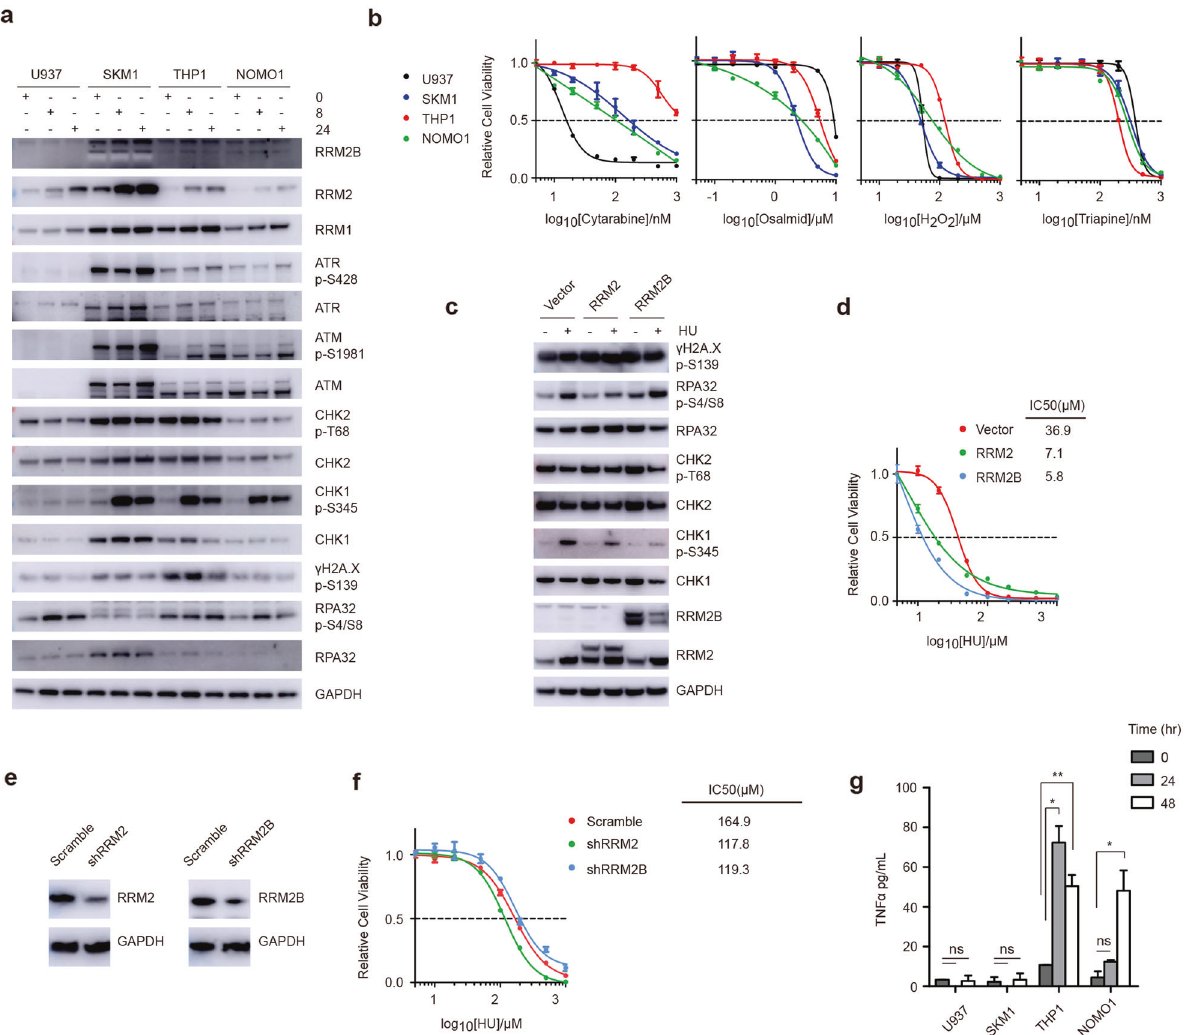
Fig. 2 RRM2 inhibition by HU is not responsible for cell killing of AML cells harbouring MLL-AF9 proteins. a Immunoblots of indicated proteins in the AML cell lines at 0, 8, 24 h with 100 μ M HU treatment. b Cell viability of treatment with indicated DNA damage agents after 72 h. c , d THP1 cells were infected with the indicated lentiviral vectors. Immunoblots ( c ) and cell viability ( d ) of the indicated cells were analyzed. The IC 50 of different cells was quanti fi ed. e , f Knockdown of RRM2 or RRM2B was performed in U937 cells. Immunoblots ( e ) and cell viability ( f ) of the indicated cells were analyzed. The IC 50 of different cells was quanti fi ed. g Concentration of TNF α in the supernatant of